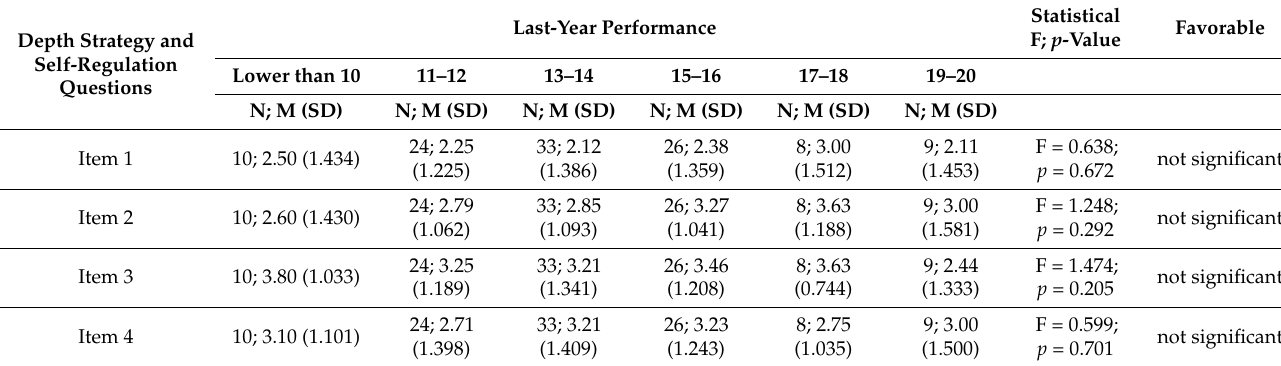
Table A2. Results of the ANOVA according to students’ last-year performances in